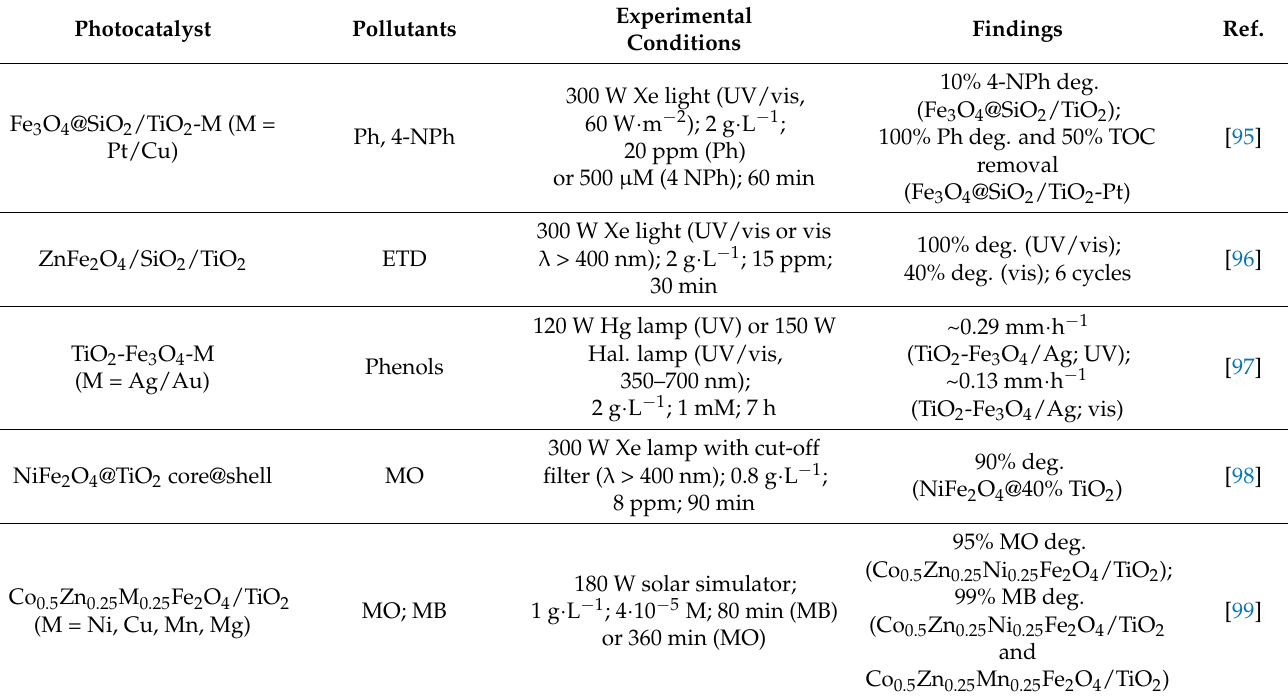
Table 3. Summary of TiO 2 -spinel ferrite